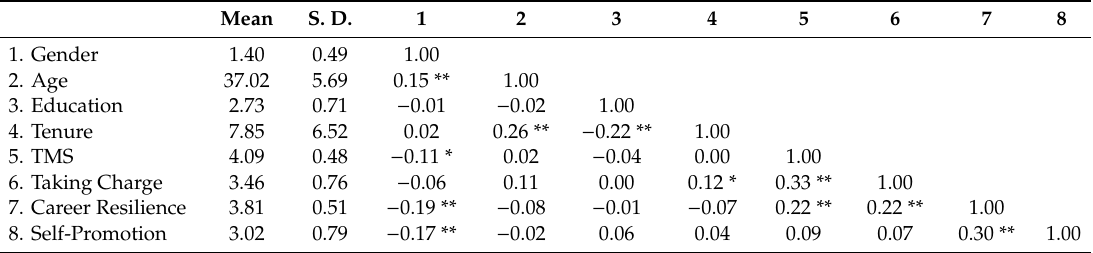
Table 3. Means, standard deviations, and correlations among